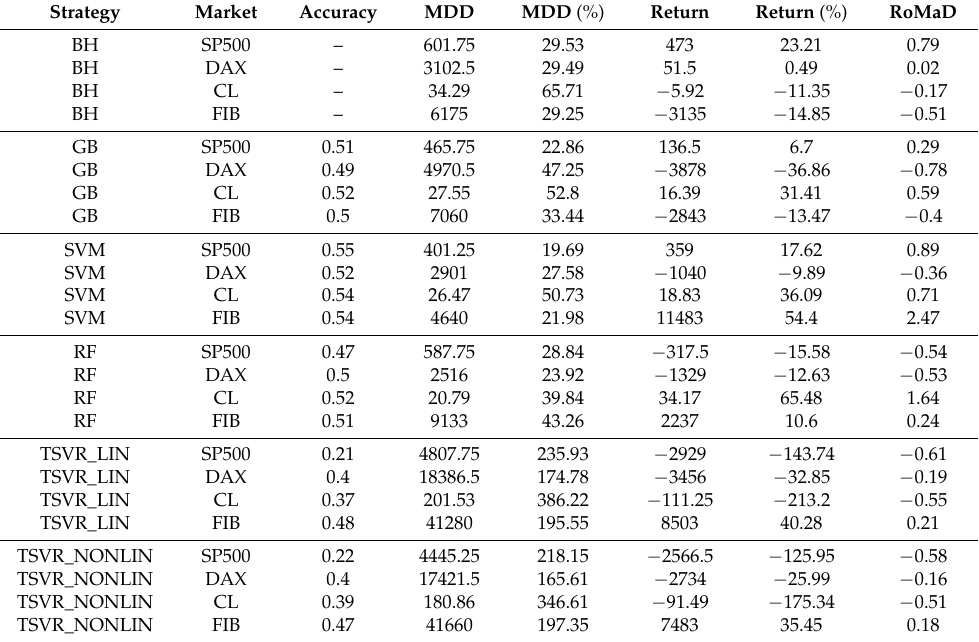
Table 6. Buy and hold and single predictors’ performance with default